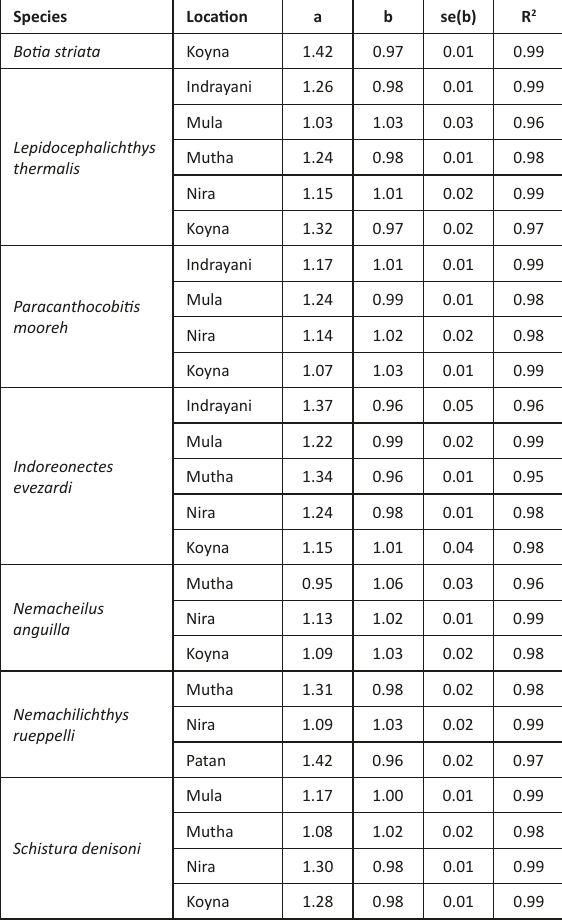
Table 4. Length-length relationship for seven loach species from five